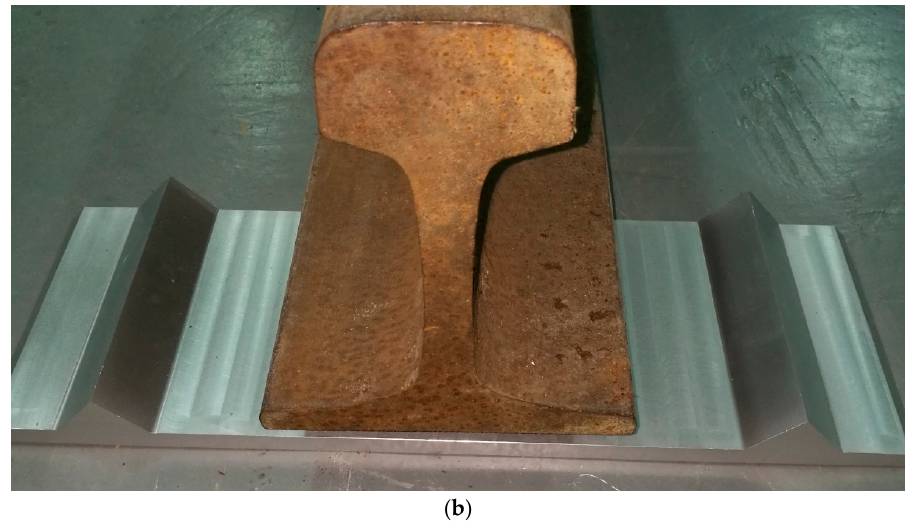
Figure 5. Special made calibration block for IRC: ( a ) full view of the calibration block; ( b ) how the calibration block is placed during calibration process.